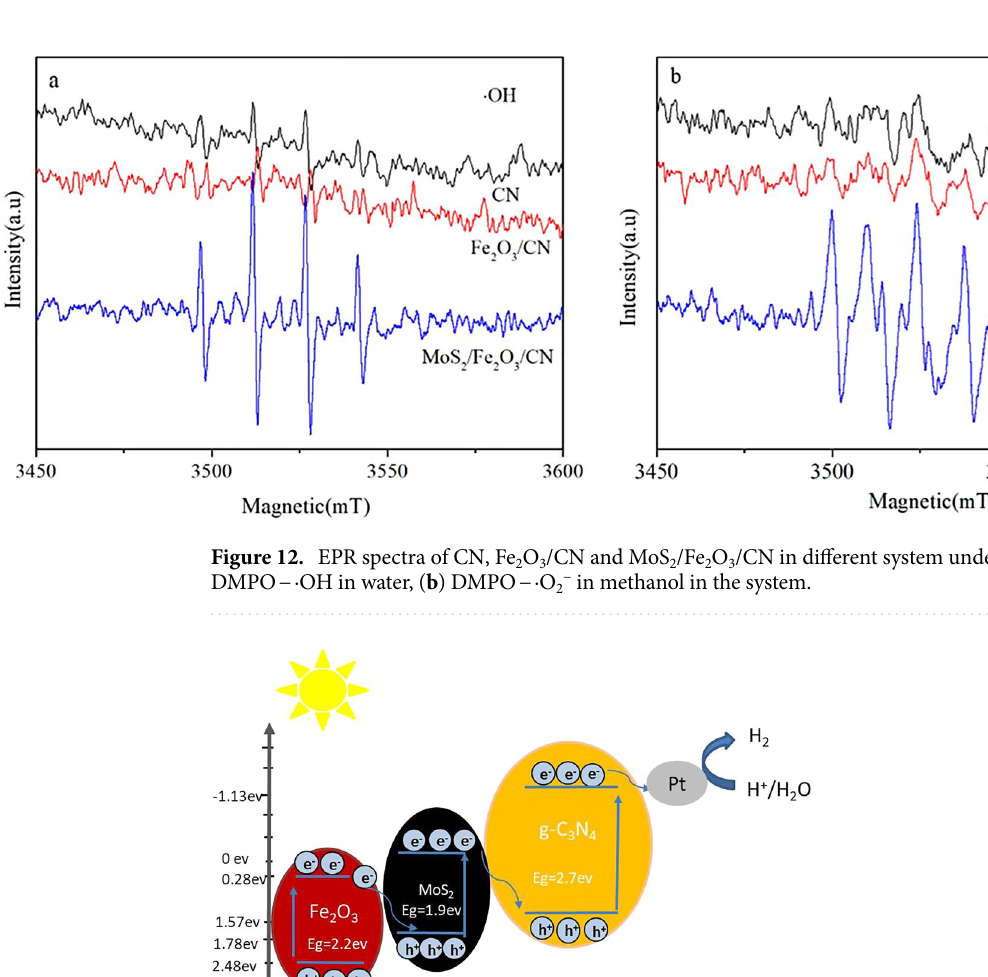
Figure 11. Transient photocurrent responses of photocatalysts.